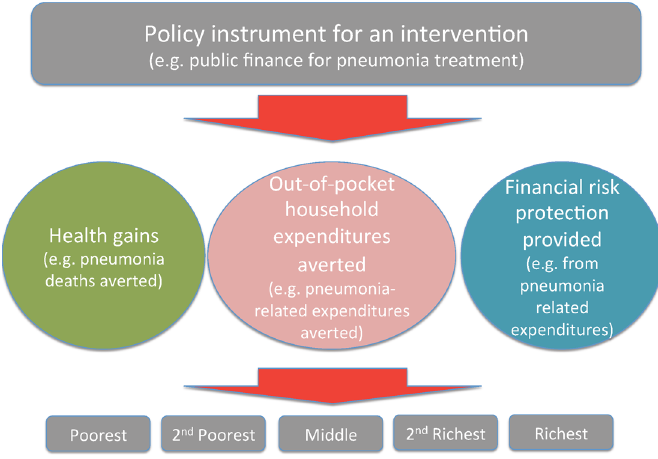
Fig 1. Summary of the conceptual structure of the methodology of extended cost-effectiveness analysis (ECEA) where we measure the program impact in four domains: (1) health gains; (2) household private expenditures averted; (3) prevention of household medical impoverishment; and (4) distributional consequences across the wealth strata of the country population.